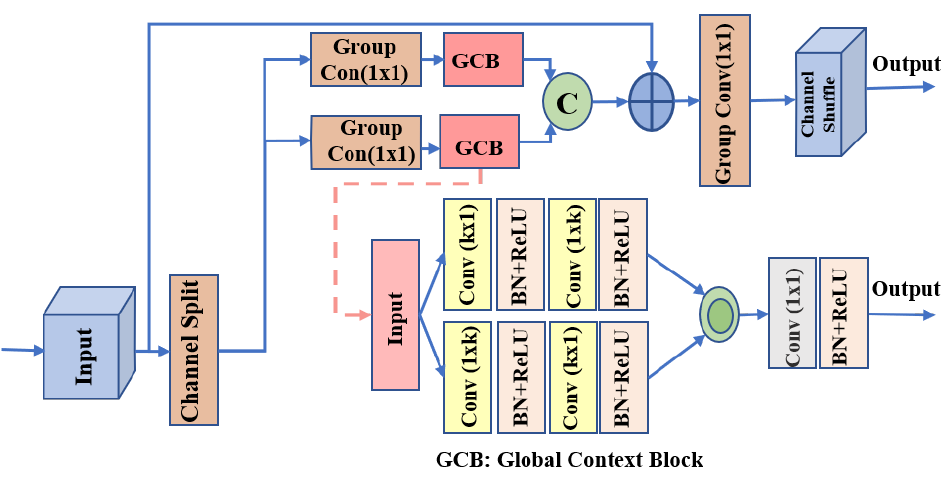
Figure 3. Dense feature extraction unit (DFEU) with large ( k × 1 ) ( 1 × k ) and ( 1 × k ) ( k × 1 ) kernel- size convolutions for k = 3, · · ·